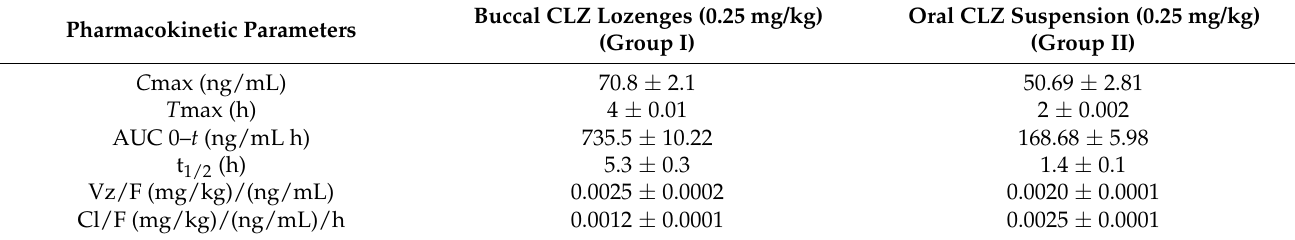
Table 5. Pharmacokinetic parameters of CLZ after administration of oral lozenges compared with oral drug suspension in rats. (mean ±